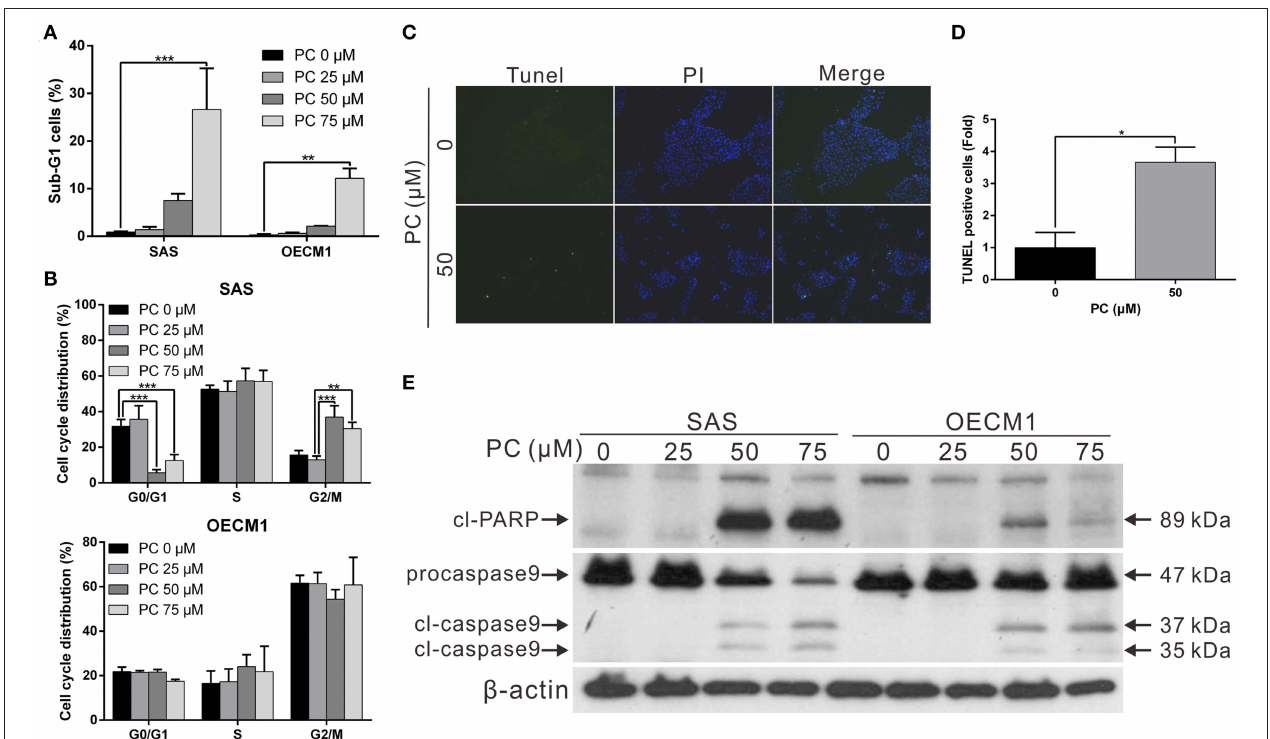
FIGURE 2 | Inhibition of cell cycle progression and promotion of apoptosis in OSCC cells by psorachromene. (A,B) Effect of psorachromene on cell cycle progression in SAS and OECM1 cells. The cells were treated with vehicles or different concentrations of psorachromene for 24h. Cell cycle distribution was analyzed by flow cytometry. (C) SAS cells were treated with or without psorachromene, and cell apoptosis was determined using a terminal deoxynucleotidyl transferase dUTP nick end labeling (TUNEL) assay. Green punctate staining (white arrows) represents TUNEL-positive cells. Apoptotic cells were identified as DAPI and